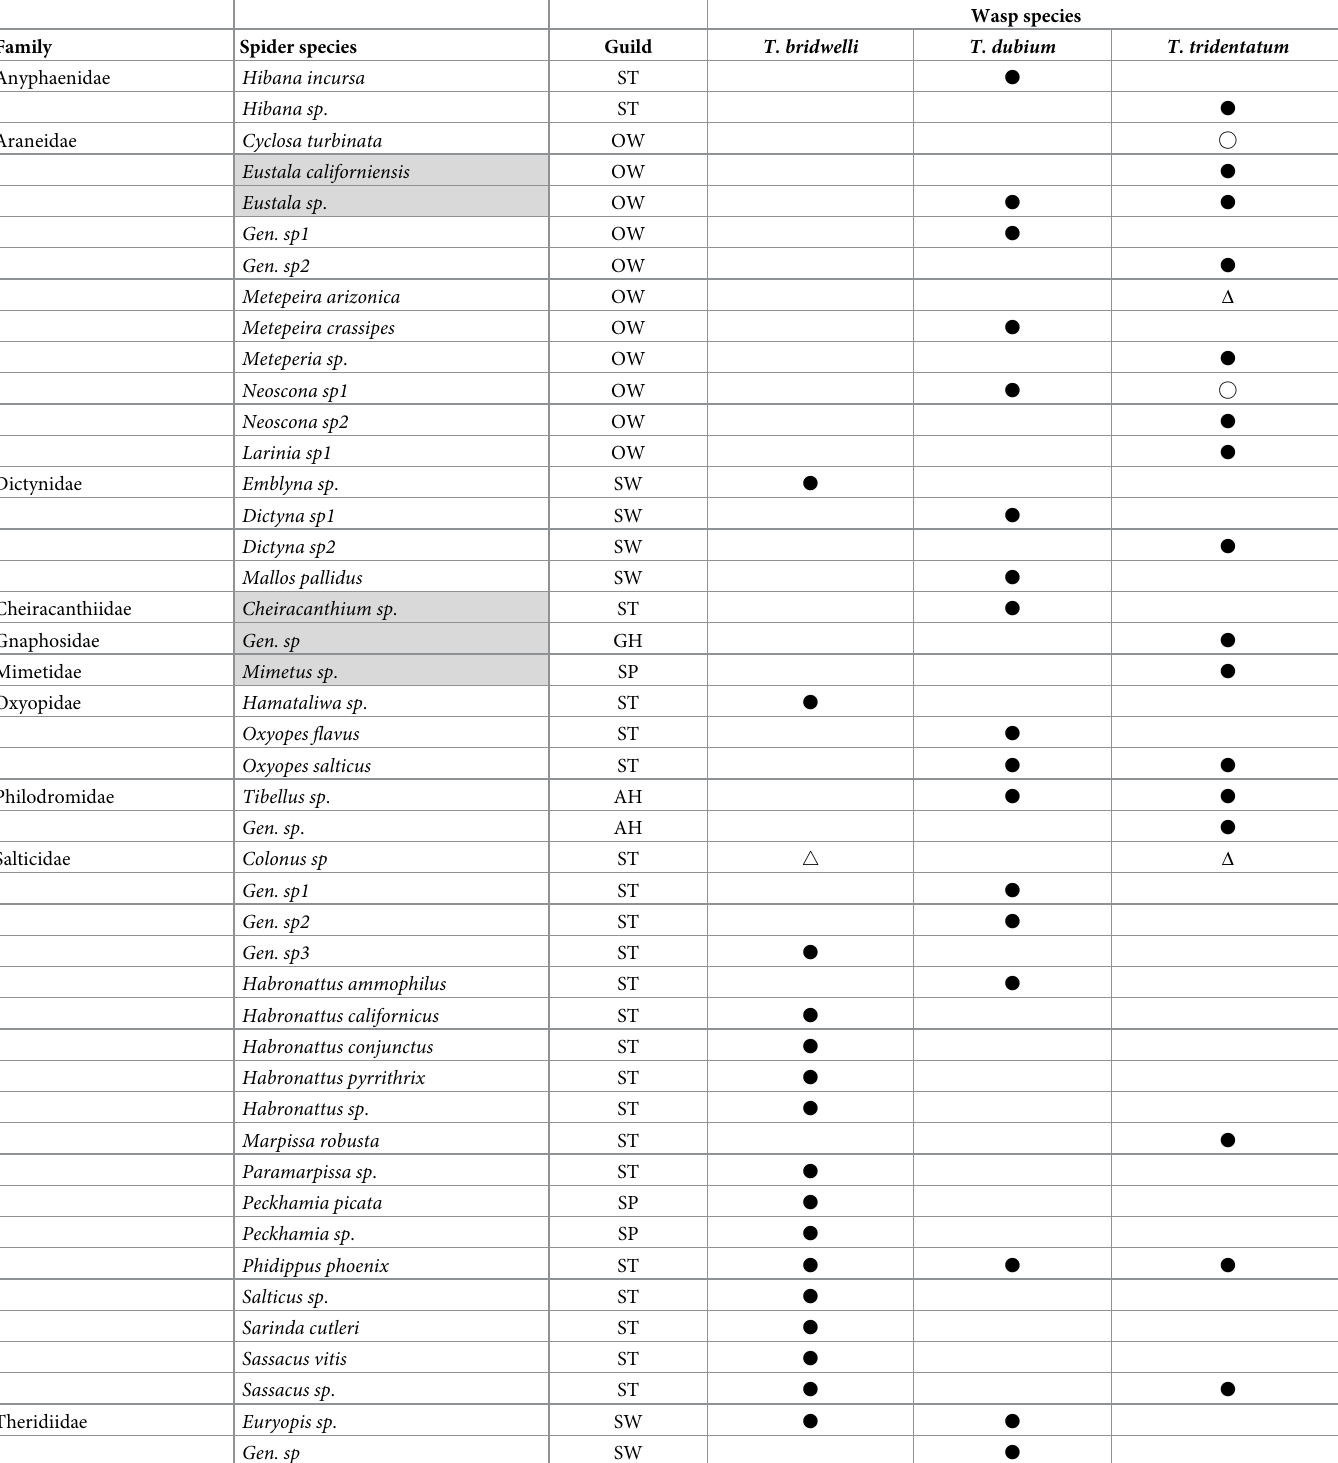
Table 2. List of spider species and their guild category captured by each mud-daubing wasp. AH = ambush hunter, OW = orb web, SW = spatial web, ST = stalker, GH = ground hunter, SP = specialist. Spiders within the nest in oasis = ● , desert = � , and both habitats = Δ . Guild categories from Cardoso et al. [33] and Uetz et al. [46].